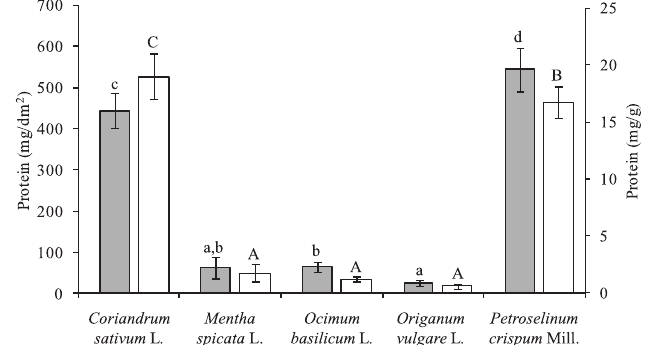
Fig. 2: P rotein content of leaves of the five studied species of medicinal and aromatic plants (mean ± SD, n = 6). Grey bars with different letters indicate values with significant differences at P< 0.05 for content expressed as mg/dm 2 , and white bars with different capital letters indicate values with significant differences at P< 0.05 for content expressed as mg/g of fresh